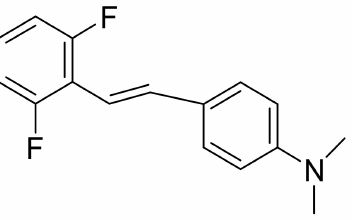
Figure 6. Stilbene analogue as a potent anticancer